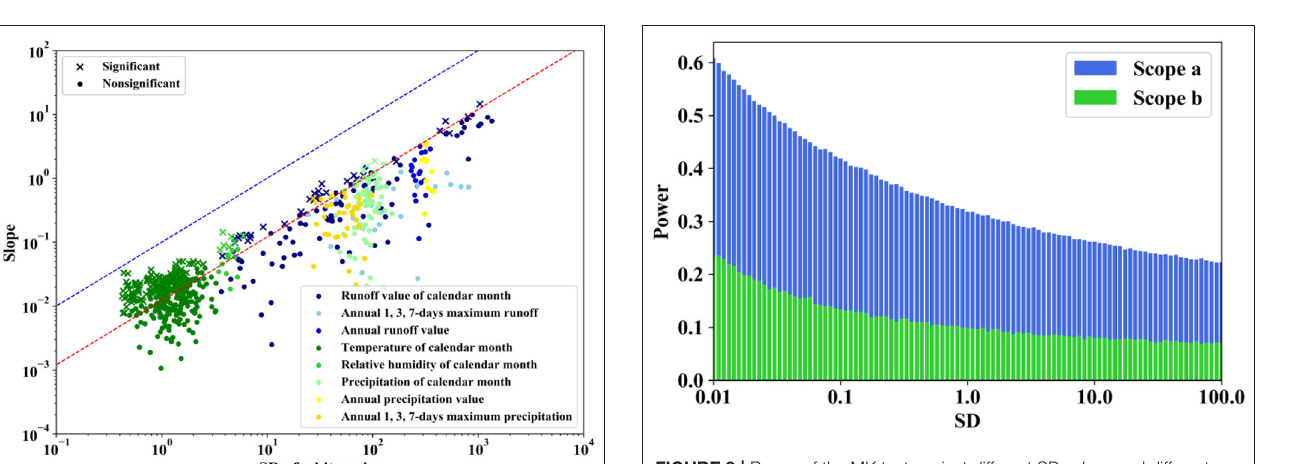
FIGURE 8 | Power of the MK test against different SD values and different slope